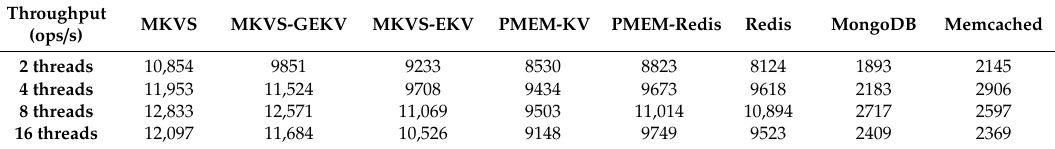
Table 6. The throughput of Workloada with different threads.